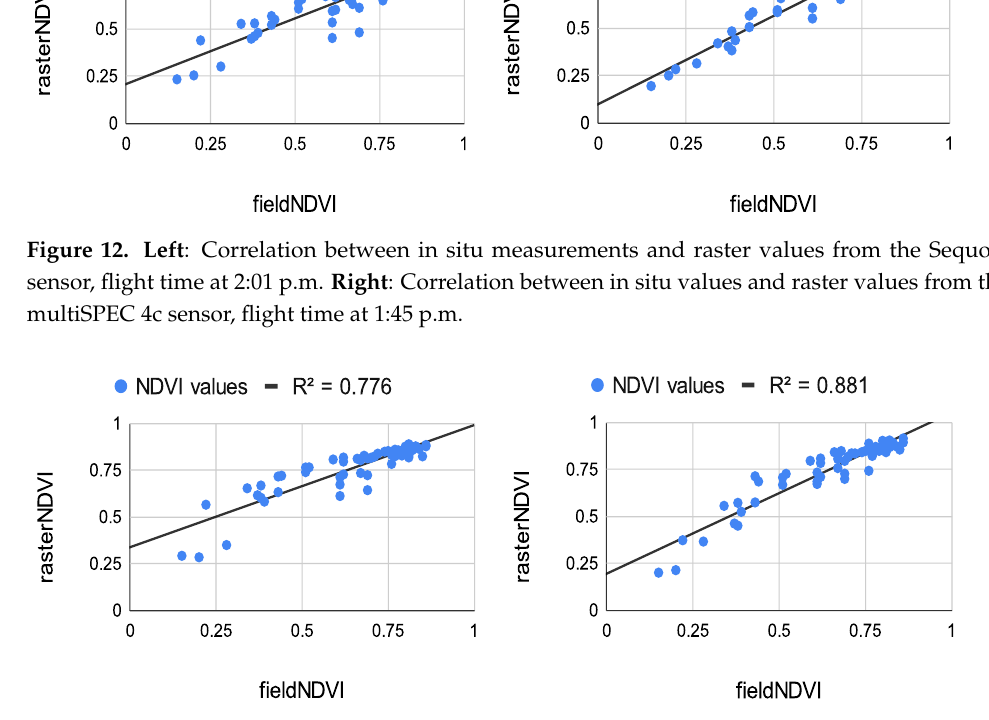
Figure 13. Left: Correlation between in situ measurements and raster values from the Sequoia sensor, flight time at 7:20 p.m. Right: Correlation between in situ measurement and raster values from the multiSPEC 4c sensor, flight time at 7:45 p.m.